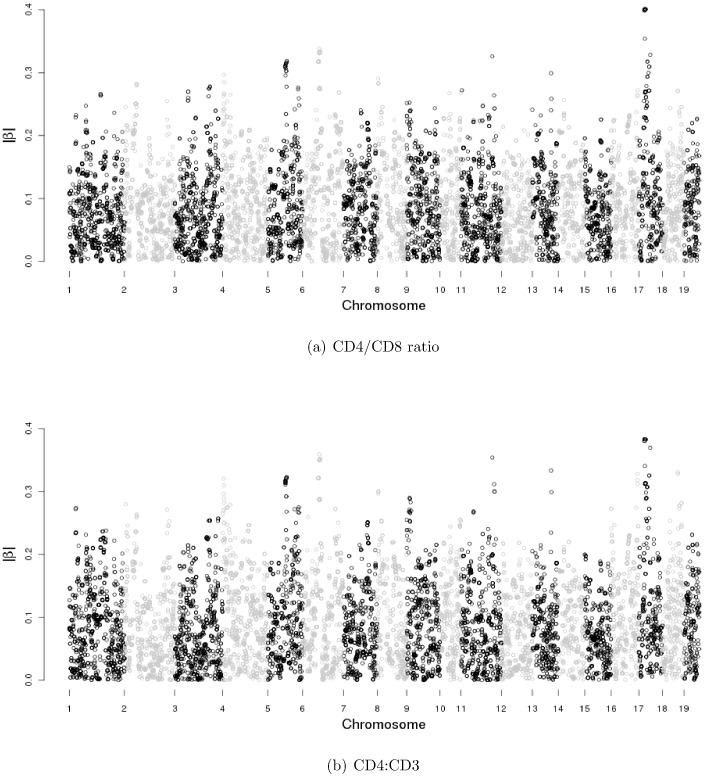
Absolute values of

 estimates from the simple linear regression on CD4/CD8 ratio and CD4∶CD3.